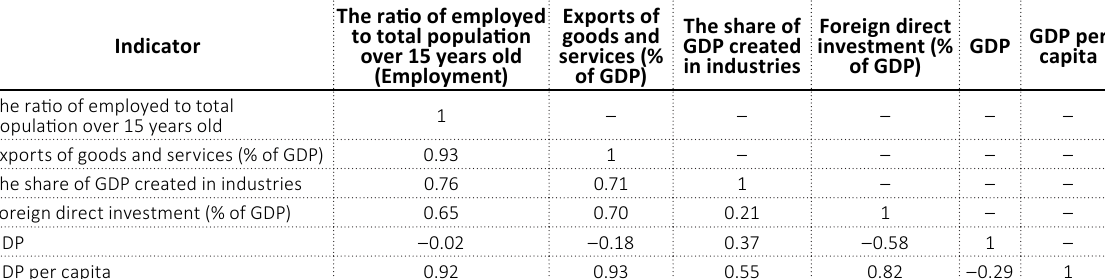
Table 1. Correlation matrix of economic development indicators